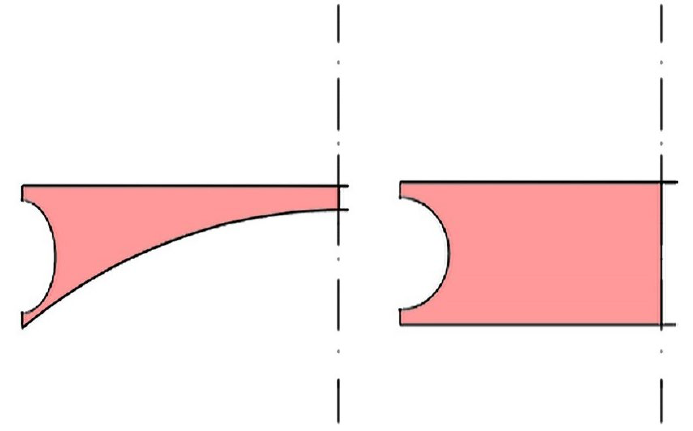
Figure 8. Trimmed void using PlaneTrimCurve.